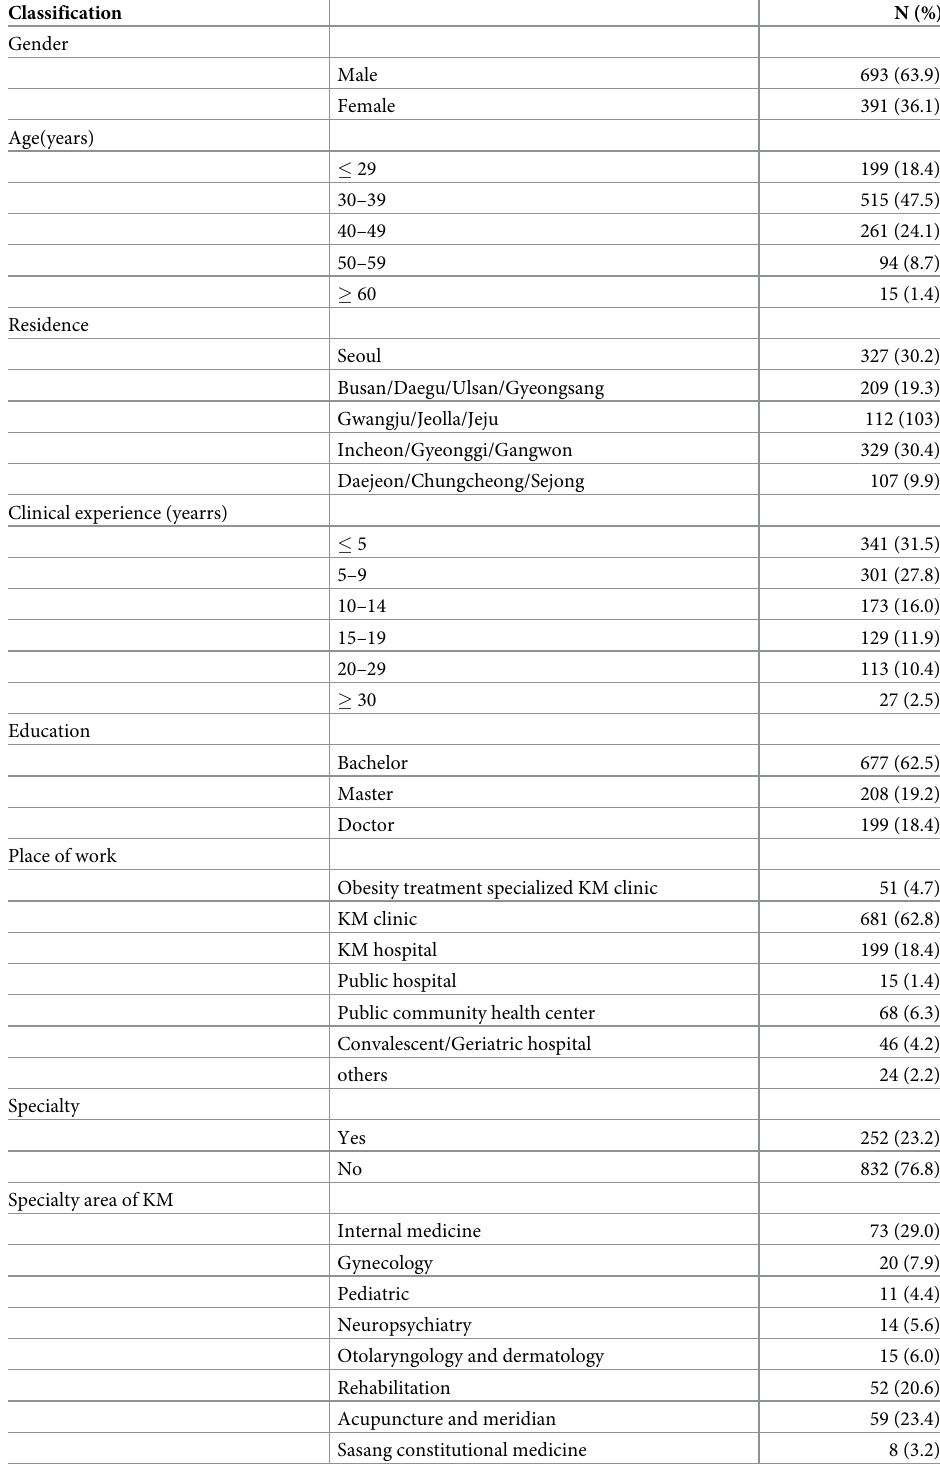
Table 1. Demographic characteristics of respondents (n =